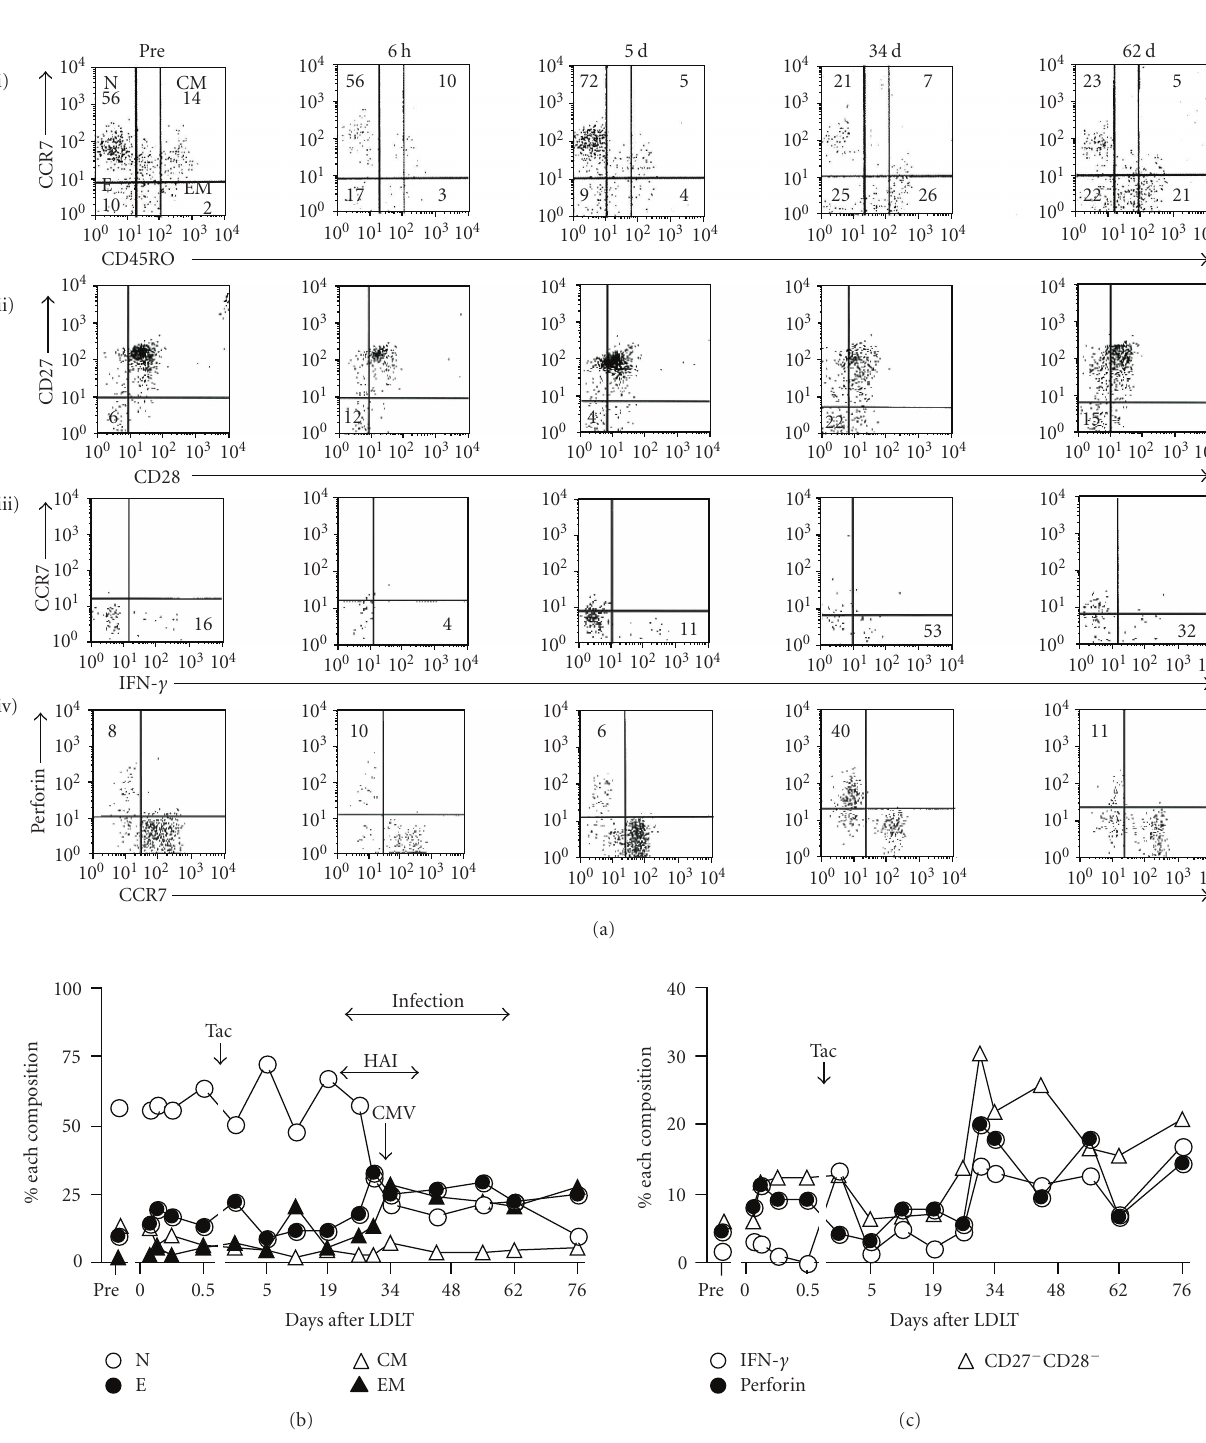
Figure 4: Changes in CD45 isoforms of CD8 + T cells, CD27 − CD28 − subsets, IFN- γ producing cells and perforin expression after LDLT in a 53-year-old, female recipient who underwent LDLT to treat HCV-related liver cirrhosis. In (a), flow cytometry, using peripheral blood nuclear cells (PBNCs) the lymphocytes were stained with monoclonal antibodies to CD45RO and CCR7. The representative dot plots show double-staining for CD8 + CCR7/CD45RO on gated lymphocytes (i), which identified 4 subsets of CD8 + : naive (CD45RO − CCR7 + ), central memory (CD45RO + CCR7 + ), e ff ector memory (CD45RO + CCR7 − ), and e ff ector T cells (CD45RO − CCR7 − ). Other dot plots show double-staining for CD27/CD28 on gated CD8 + T cells (ii), CCR7/IFN- γ on gated CD8 + CD45RA + cells (iii), perforin/CCR7 on gated CD8 + CD45RO − cells (iv). Cells in quadrants are presented as ratios (%). Right low (c), proportions of perforin and IFN- γ expression are expressed as ratios (%) of CD8 + T cells. Pre, pre-LDLT; Tac, tacrolimus. (b) N, naive T cells; E, e ff ector T cells; CM, central memory T cells; EM, e ff ector memory T cells; and HAI, hepatic artery flow interruption. (c) IFN- γ , interferon-gamma; and CD27 − CD28 − , CD27 − CD28 −